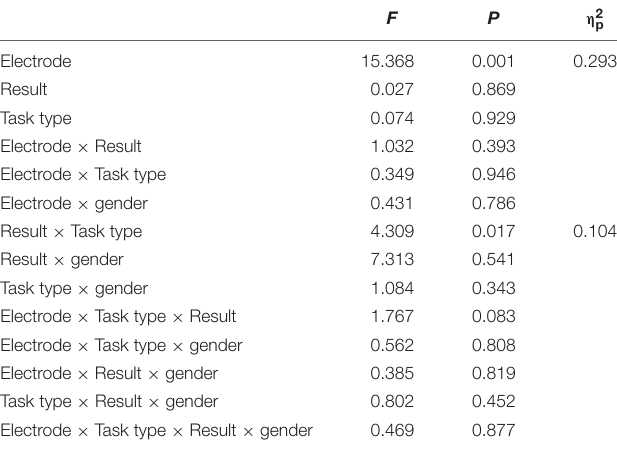
TABLE 3 | Results of P3 Analysis.